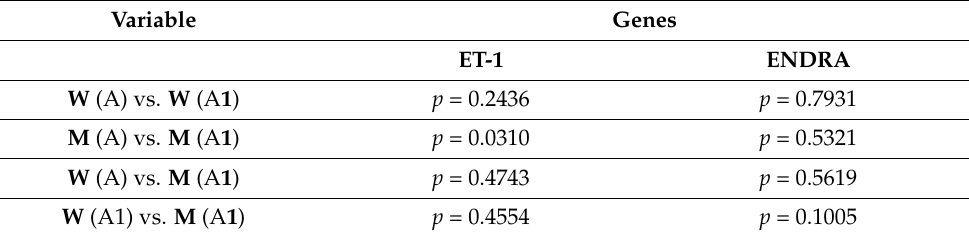
Table 9. Transcriptional activity of endothelin-1 genes and its A-type receptor among patients after myocardial infarction before (A) and after early post-hospital cardiac rehabilitation (A1) taking into account age. Genes Under Study Parameter Variable ET-1 Variable ENDRA Patients age R = 0.225 R = p = 0.1135 A vs. A1